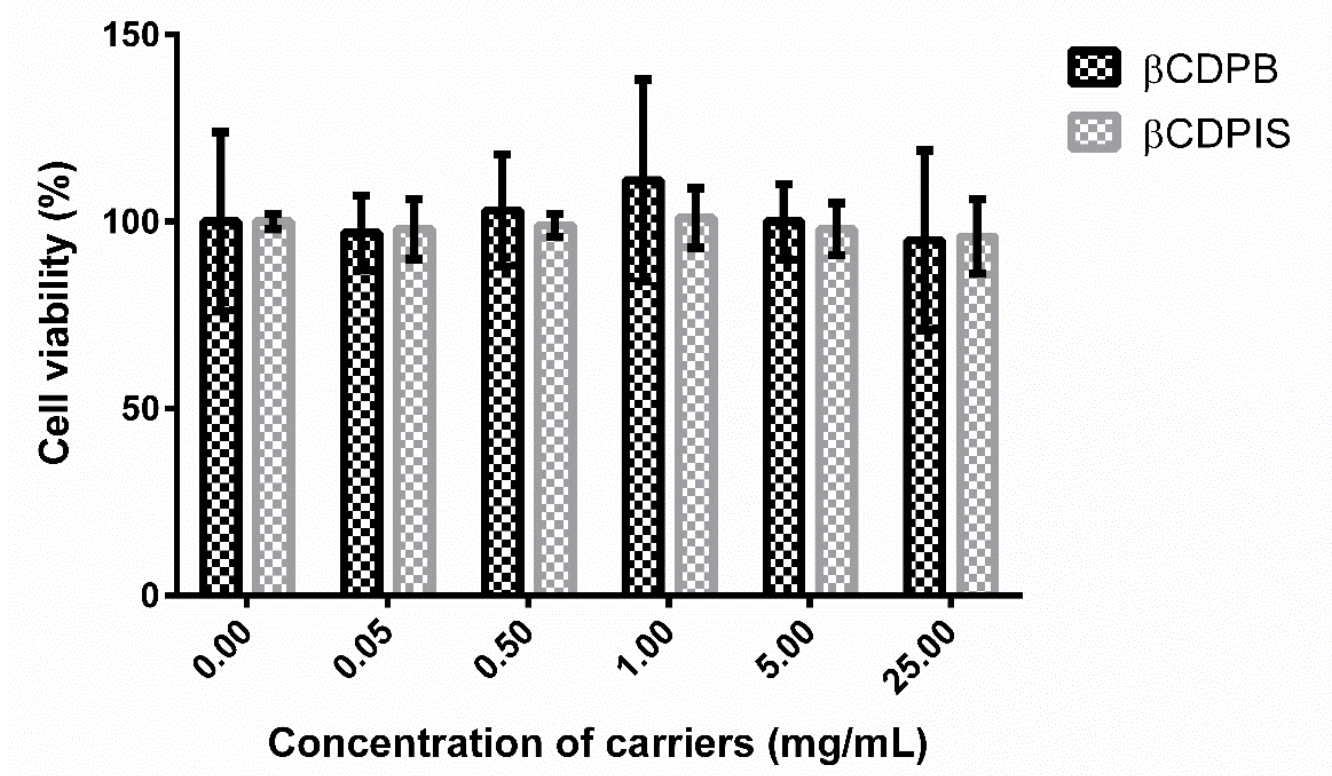
Figure 9. MTT assay results with increasing concentration of β CDPB (black) and β CDPIS (gray) after 30 min incubation (data are presented as means ± SD, n = 5).